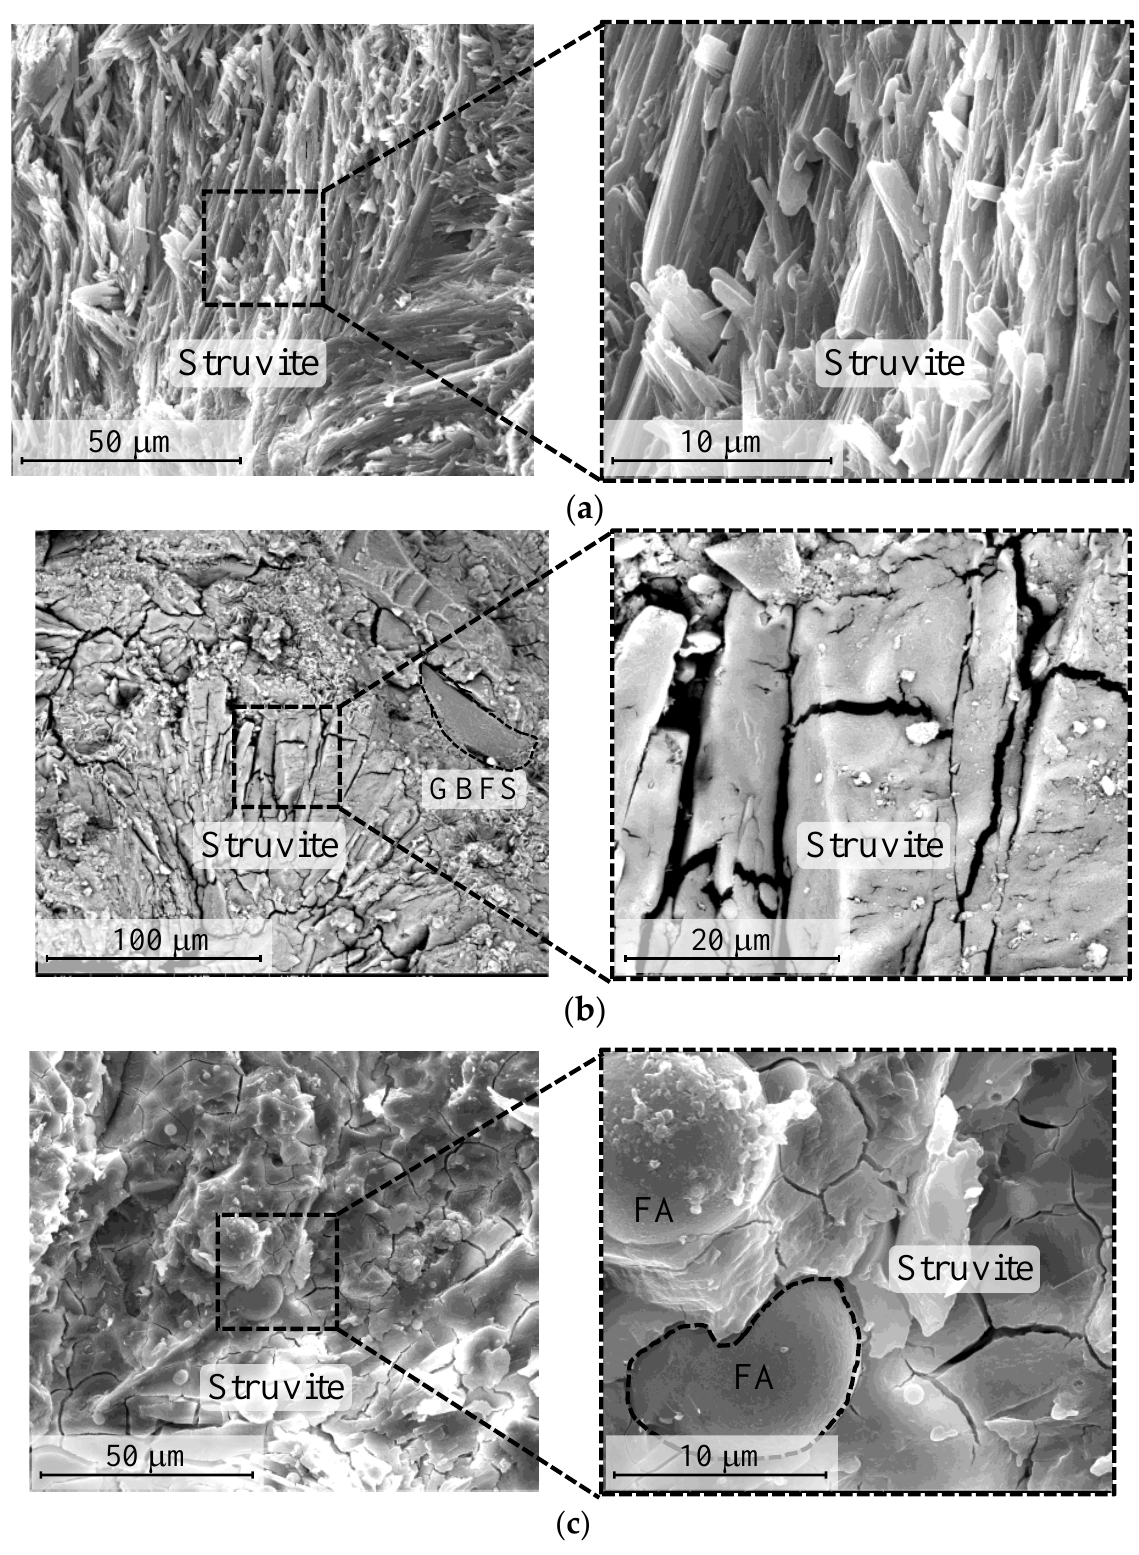
Figure 6. SEM observations of ( a ) MPC, ( b ) MPC/FA and ( c ) MPC/GBFS.